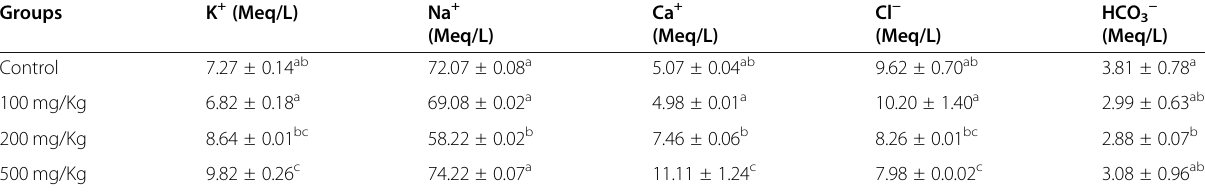
Table 5 Effects of Dennettia tripetala methanol leaf extract on Kidney Electrolyte Profile